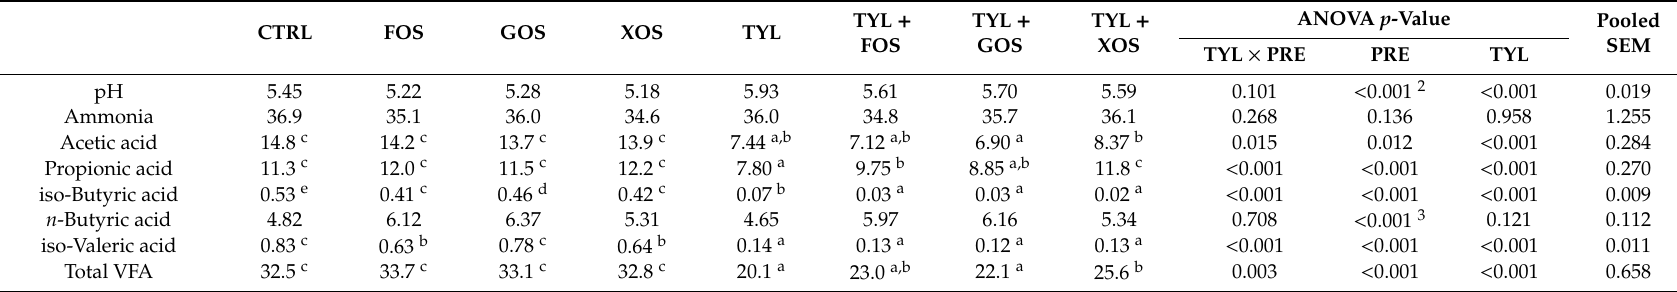
Table 2. pH values and concentrations (mmol / L) of ammonia and volatile fatty acids after 24 h of an in vitro incubation of canine fecal inoculum with a control diet supplemented with some prebiotics and / or tylosin tartrate 1